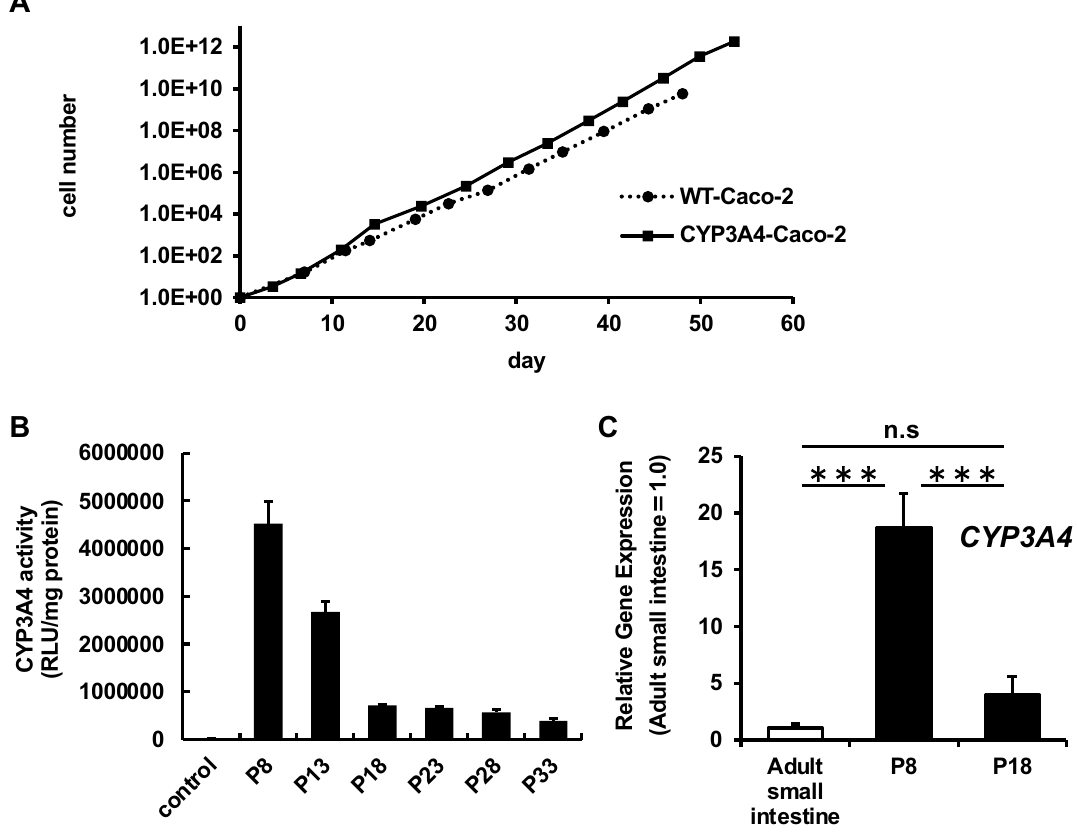
Figure 3. Temporal characterization of CYP3A4-Caco-2 cells. The cells were seeded into the 12-well dishes. ( A ) WT-Caco-2 cells and CYP3A4-Caco-2 cells (#1) were cultured and cell growth was analyzed by obtaining a cell count at each passage. The results are represented as means ± SD ( n = 3, technical replicate). ( B ) Temporal CYP3A4 activity in WT-Caco-2 cells and Dox-treated CYP3A4-Caco-2 cells (passage number 8, 13, 18, 23, and 28) were examined using P450-Glo assay kit. ( C ) The gene expression levels of CYP3A4 in human adult small intestine (adult small intestine) and CYP3A4-Caco-2 cells (#1) (passage number 8 and 18) with Dox treatment were measured by real-time RT-PCR. Statistical significances were evaluated by one-way ANOVA followed by Tukey’s post-hoc tests (*** p < 0.001). All data are represented as means ± S.D. ( n = 3, technical